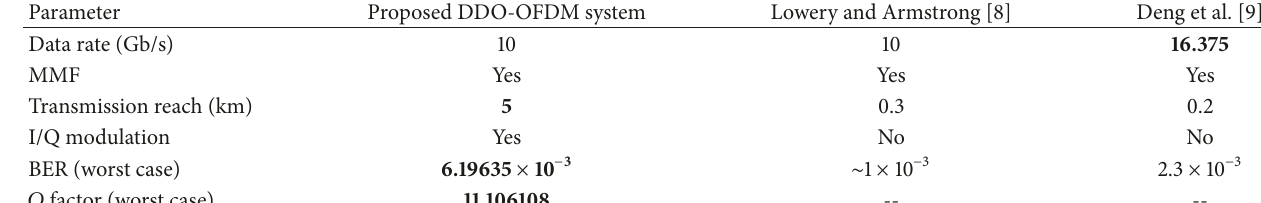
Table 3: Comparative performance analysis of the proposed work.